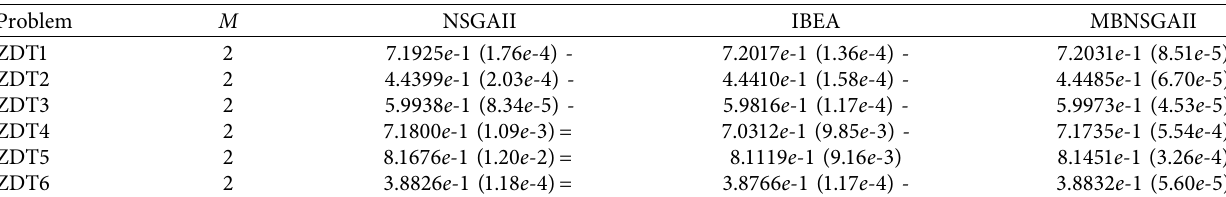
Table 5: Experimental results of HV on ZDTs (mean and standard deviation).